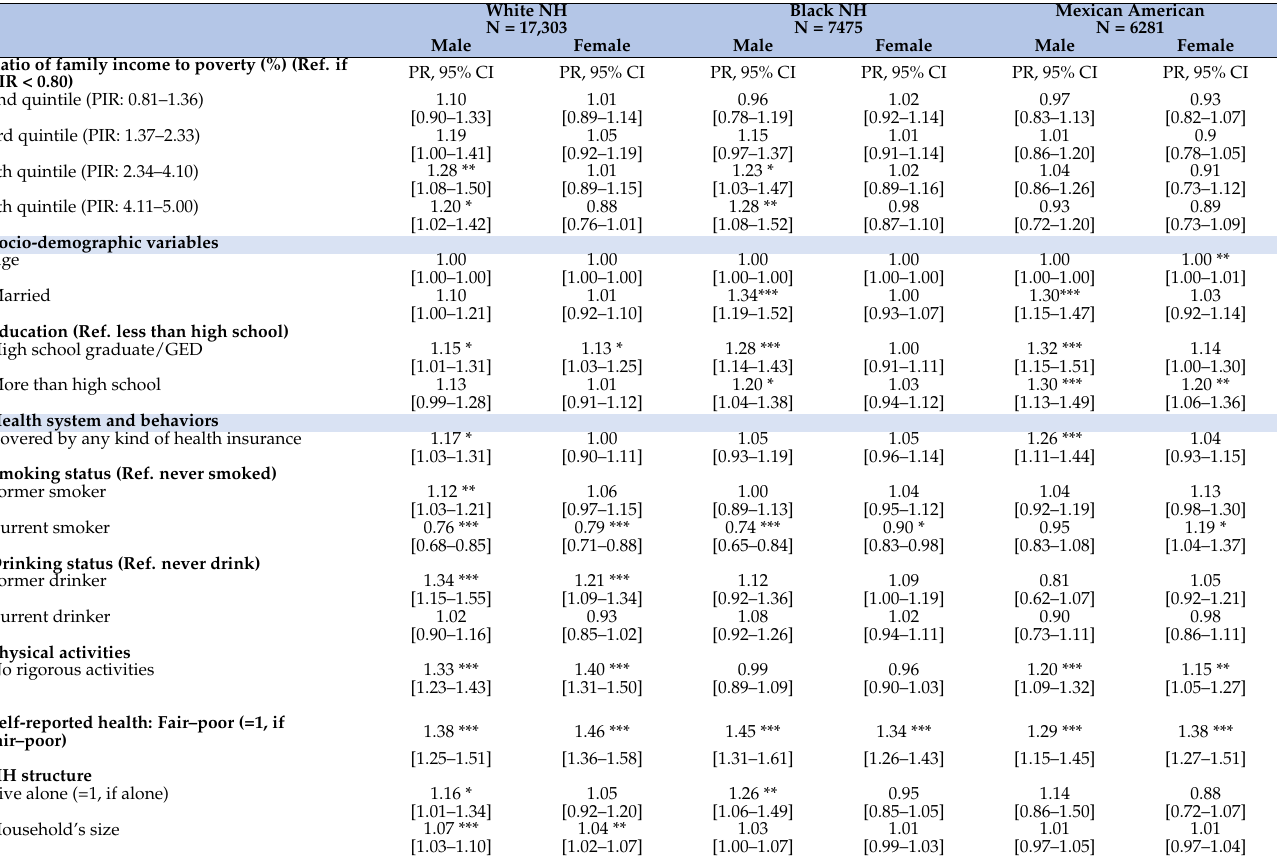
Table 4. Association between income differences and obesity across racial/ethnic groups in U.S. adults,